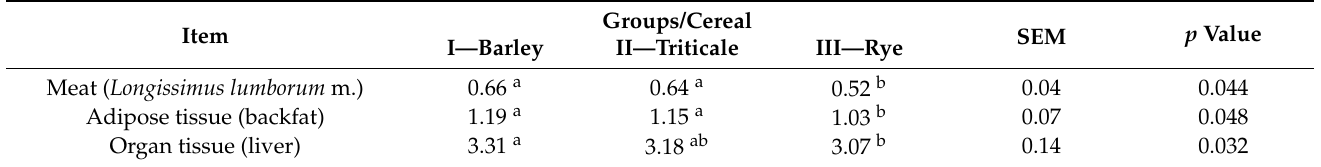
Table 6. Cholesterol content in different tissues (mg/g) of fattened pigs.